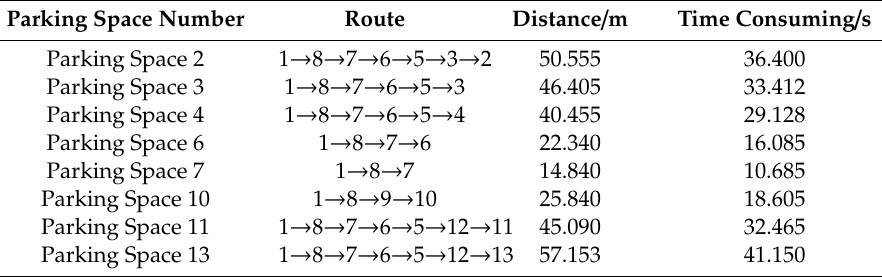
Table 5. Driving route of each parking space under the improved